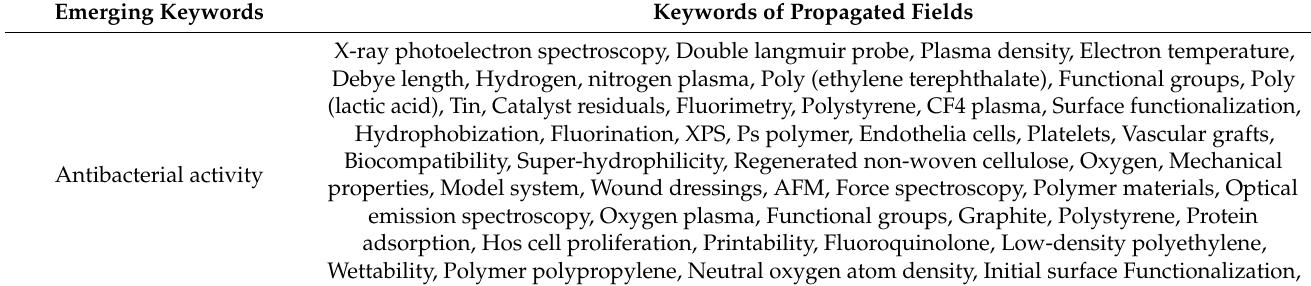
Figure 8. Example of impact analysis of “Surface modification of polyimide films using unipolar nanosecond-pulse DBD in atmospheric air” (2010). Table 3. Plasma surface treatment of emerging technology candidates and keywords that have spread to other